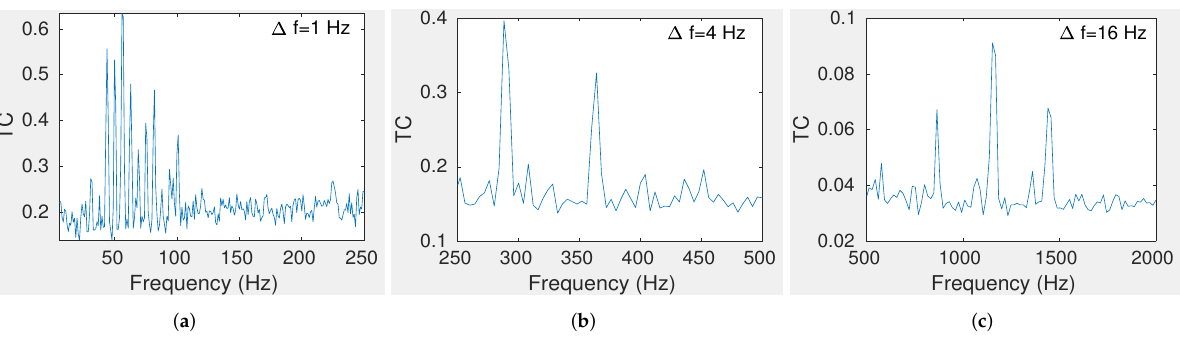
Figure 3. The temporal coherence TC distribution of ship-radiated underwater sound at 65% propeller pitch ratio and at frequencies ( a ) below 250 Hz with ∆ f = 1 Hz, ( b ) between 250 Hz and 500 Hz with ∆ f = 4 Hz, and ( c ) between 500 Hz and 2000 Hz with ∆ f = 16 Hz. The 7th to 13th harmonics of cylinder firing rate CFR are prominent in ( a